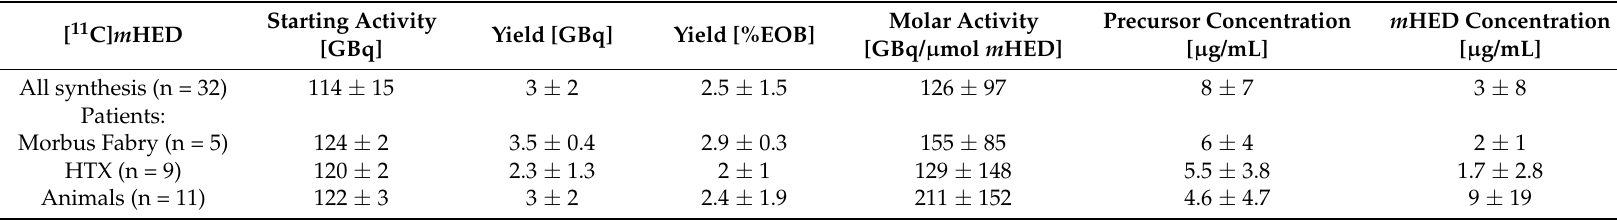
Table 1. Overview of overall synthesis data (excluding synthesis for the purpose of condition testing and fail synthesis), as well as synthesis data for the respective pre-clinical and clinical